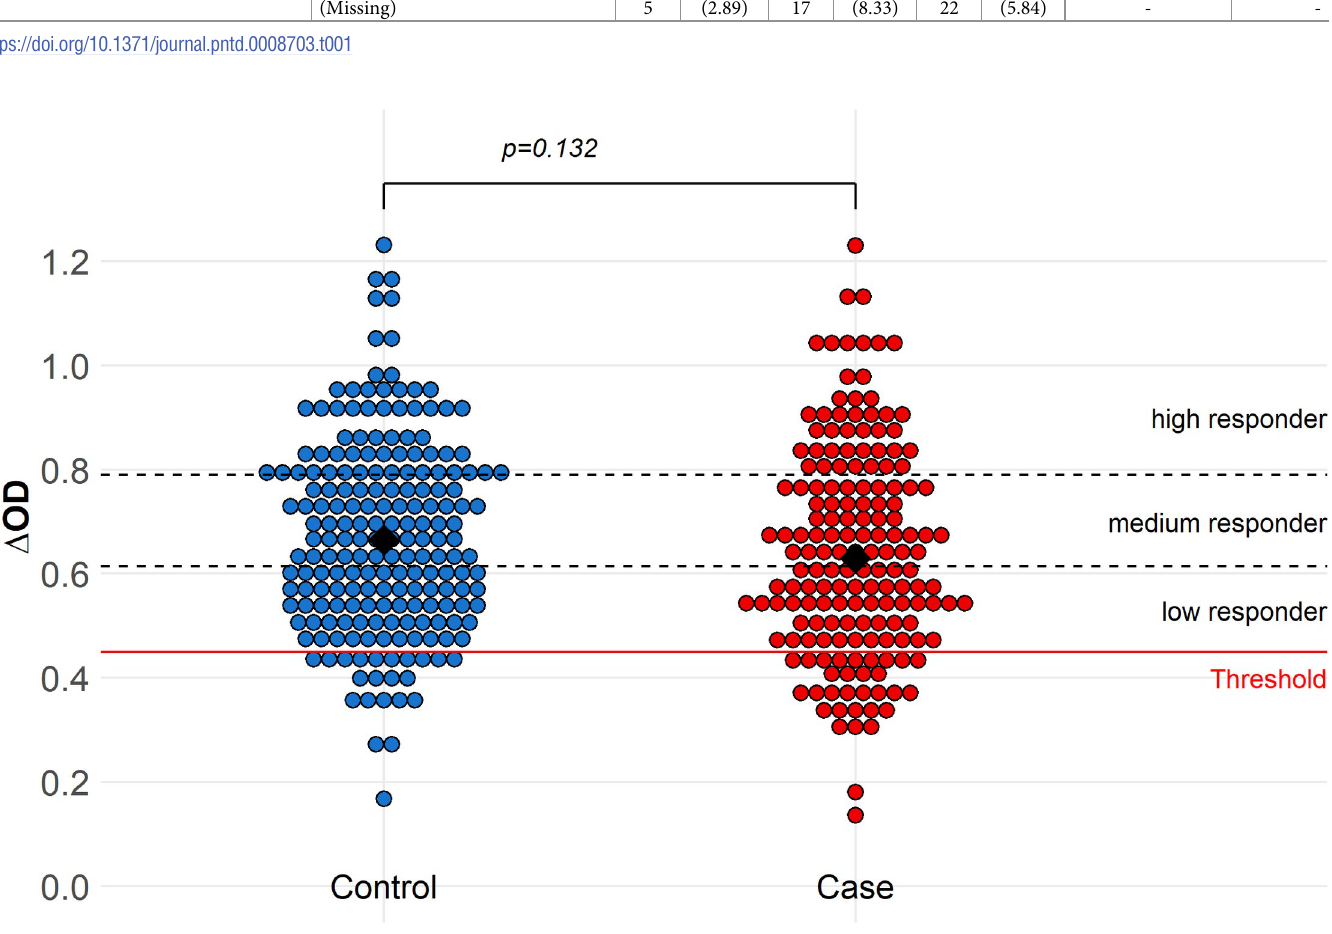
Fig 3. Immune response to Aedes saliva ( Δ OD) in dengue case and control patients. The black diamonds represent the response medians. The dashed lines represent the limits of each group of intensity of response. The red line at 0.45 indicates the specific immune threshold TR defined from individuals not exposed to Ae aegypti .